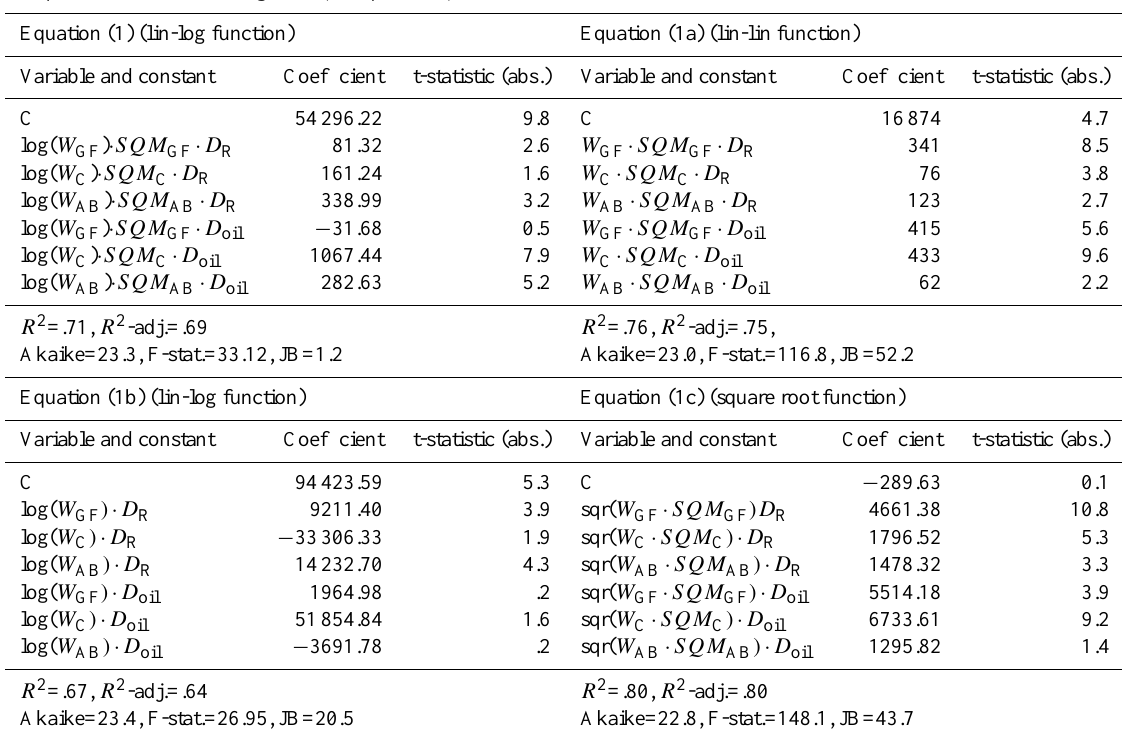
Table 4. Regression analysis (Eqs. 1, 1a, 1b and